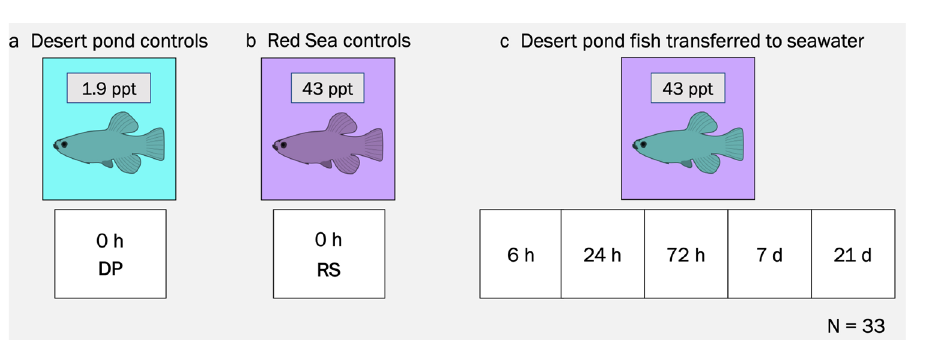
Figure 1. Sampling locations and target organism. ( a ) Map of the region with inset ( b ) showing the specific sampling locations in the central western region of Saudi Arabia. ( c ) Photos of the sampling sites. ( d ) Pictures of collected male (top) and female (bottom) Arabian pupfish.